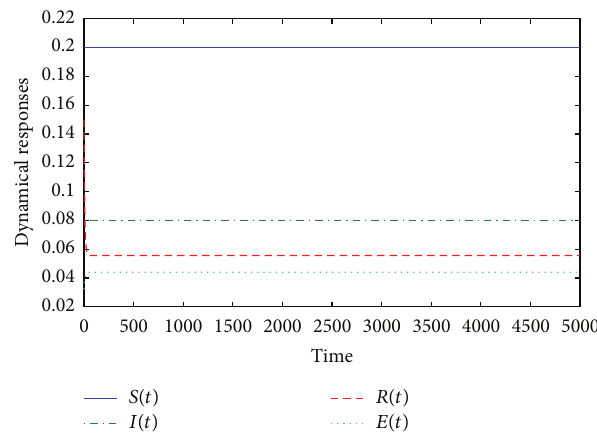
Figure 2: Dynamical responses of model system (125) with state feedback controller, which shows that model system (125) is stable around (0.2,0.08, 0.0557, 0.0439) .